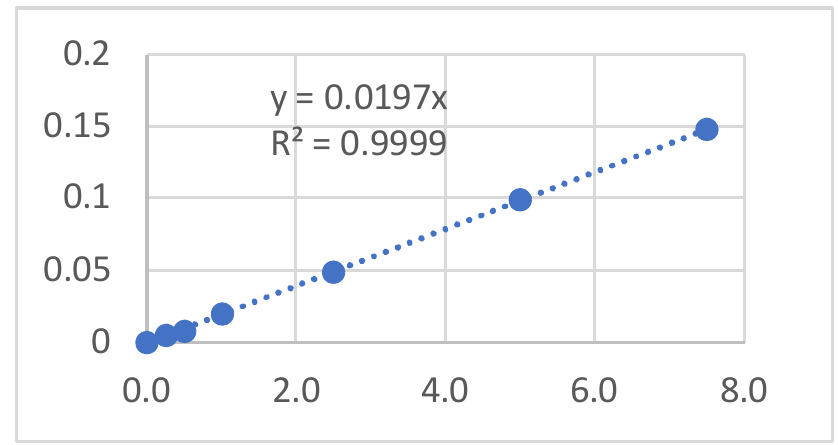
Figure 5. Cu calibration graphs.